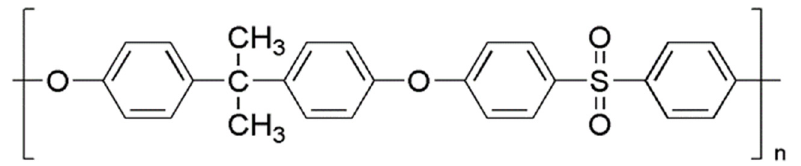
Figure 1. Chemical structure of